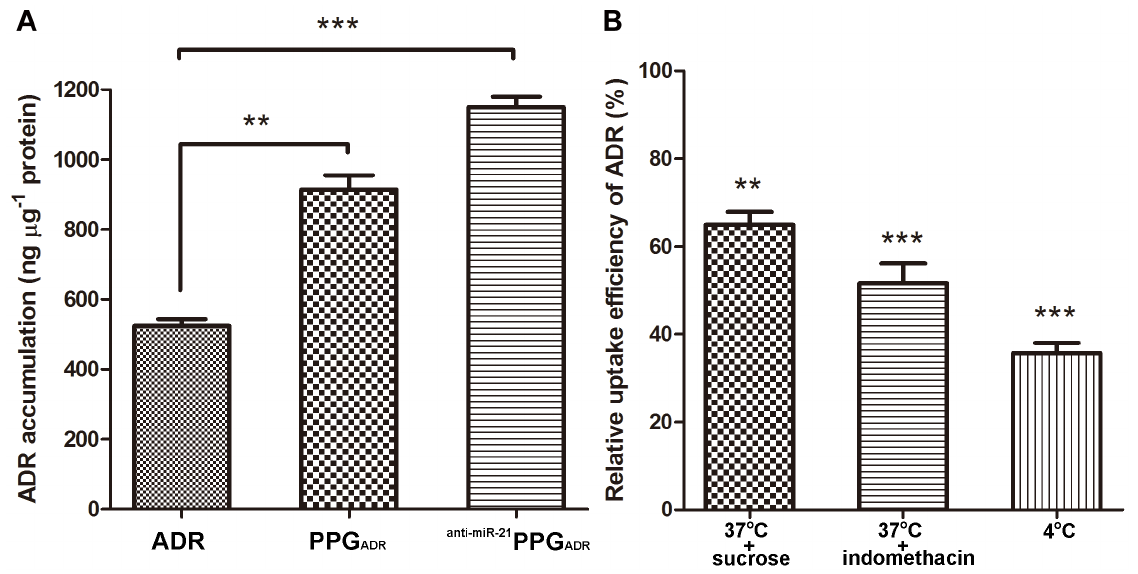
Figure 7. ADR accumulation and uptake mechanism in MCF-7/ADR cells. (A) ADR accumulation in MCF-7/ADR cells incubated with ADR, PPG ADR or anti-miR-21 PPG ADR for 24 h. The ADR concentration was determined by HPLC and normalized to total cell protein. Data are shown as the mean 6 SD, n=3. (B) Cellular uptake efficiency of ADR in MCF-7/ADR incubation with anti-miR-21 PPG ADR at 37 u C after treated with sucrose, at 37 u C after treated with indomethacin and at 4 u C. The uptake efficiency of ADR in MCF-7/ADR incubation with anti-miR-21 PPG ADR at 37 u C without any treatment was set as control. Data are means 6 SD for three separate experiments, ** P , 0.01, *** P , 0.001.